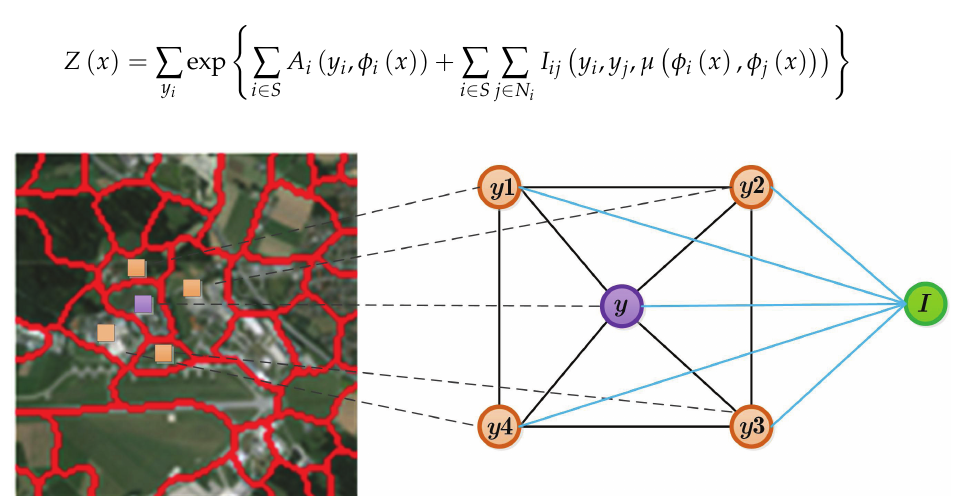
Figure 4. The spatial relationships are modeled by the conditional random field. The image is first partitioned into several regions, then the CRF is used to model the spatial relationships among those regions, where the node y represents a region, while x denotes the whole